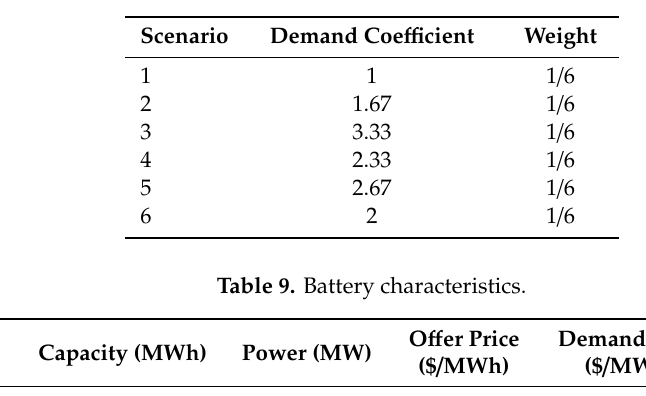
Table 8. Demand characteristics.